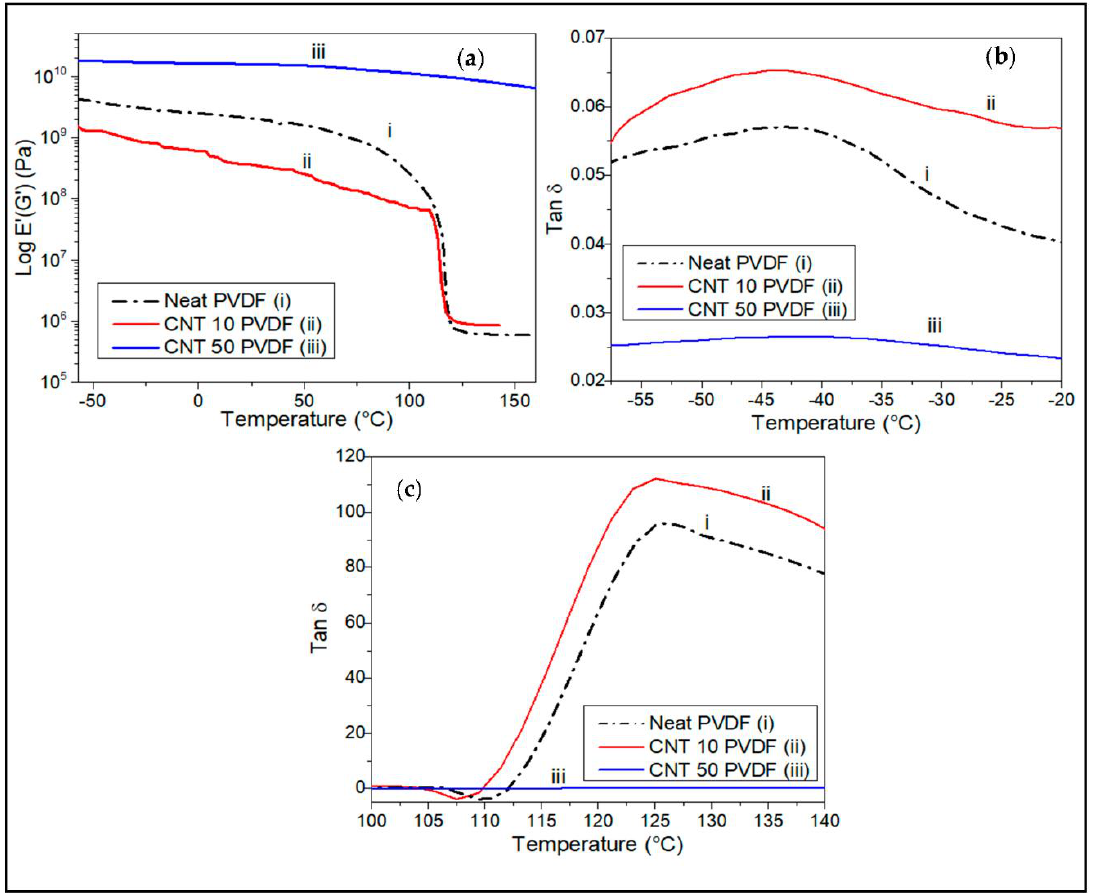
Figure 8. DMA plots comparing the ( a ) effect of CNT loading on the storage modulus of the PVDF CNT at an oscillatory frequency of 1Hz under tension. Tan delta peaks show ( b ) dynamic T g between −55 °C and −20 °C and ( c ) T m between 105 °C and 140 °C.